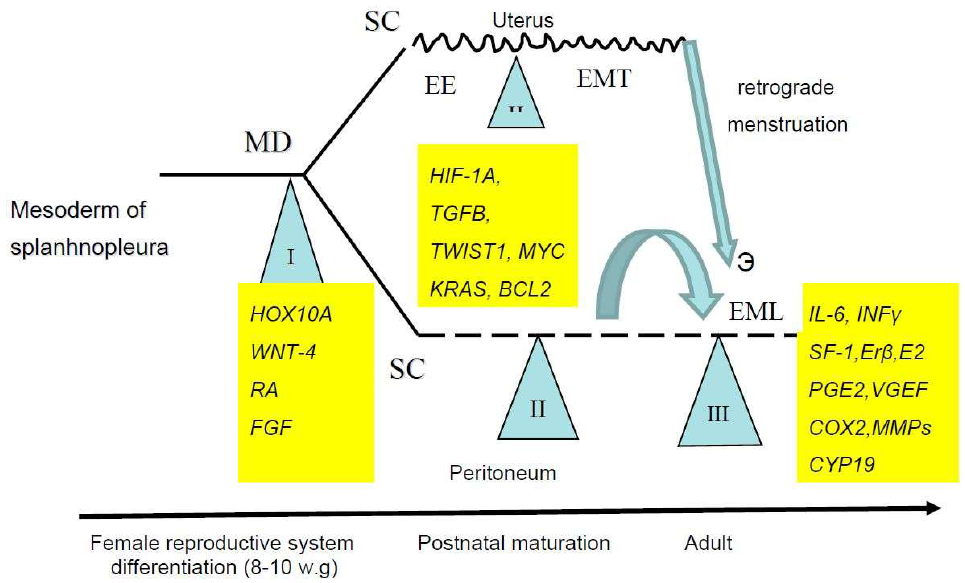
Figure 1. Sensitive periods in the Endometriosis Development Program. SC, stem cells, MD, Mullerian ducts, EE, eutopic endometrium, EMT, epithelial–mesenchymal transition, EML, endometriotic lesions, w.g., weeks of gestation.